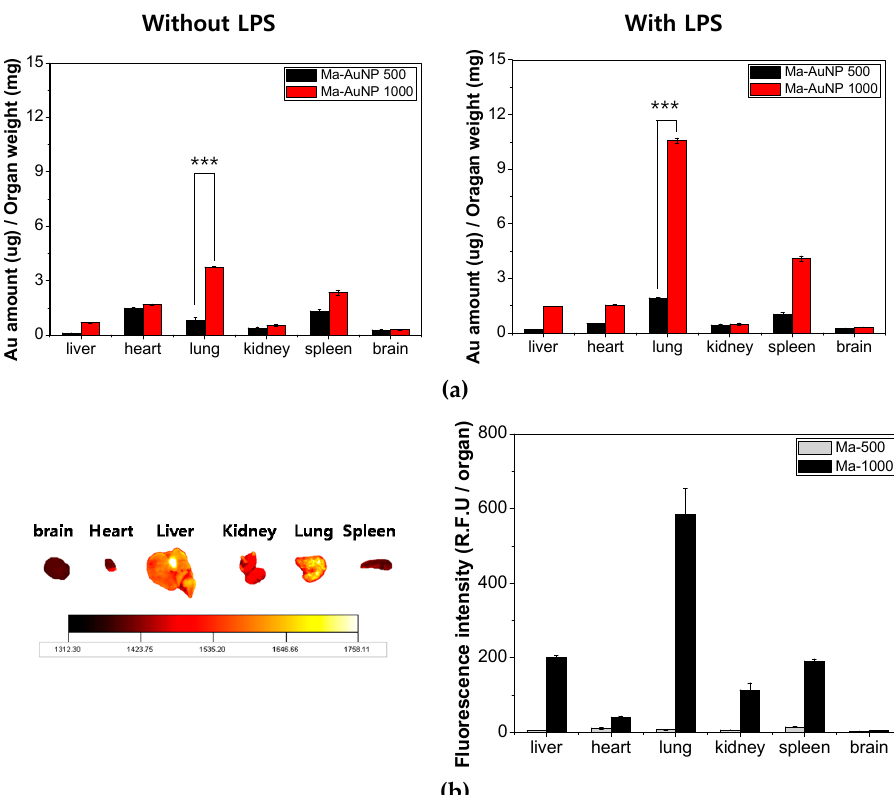
Figure 3. ( a ) Ex vivo Au ion quantification analysis in the major organs (brain, heart, liver, kidneys, lungs, and spleen) of mice with or without LPS-treatment. Au ions were extracted and detected from the AuNPs, which were loaded into the macrophages. (statistical analysis mark means *** P<0.05) ( b ) Ex vivo fluorescence image and quantification analysis of the major organs (brain, heart, liver, kidneys, lungs, and spleen) at a 6 h post-injection. (determined by ICP-MS) (Ma-AuNP : AuNP loaded Macrophage, Ma: Macrophage, 500: 500 × 10 4 ea-macrophages, 1,000: 1,000 × 10 4 ea-macrophages) (the scale bare means the Mean of intensity). Electronics 2020 , 9 , x FOR PEER REVIEW